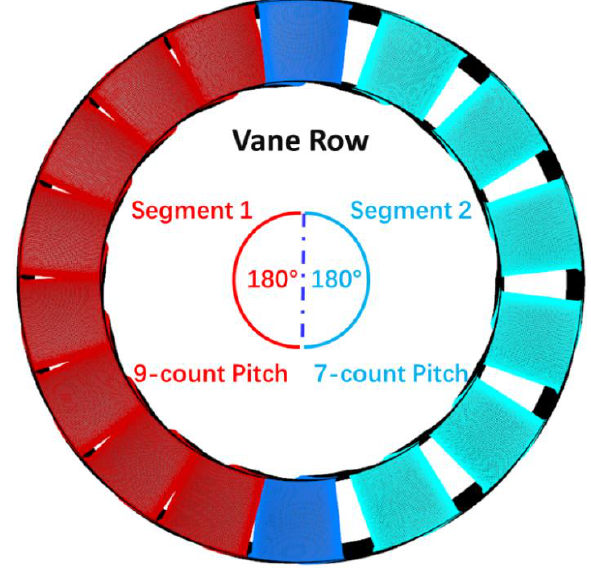
Figure 4. Schematic of Half-and-Half Layout.